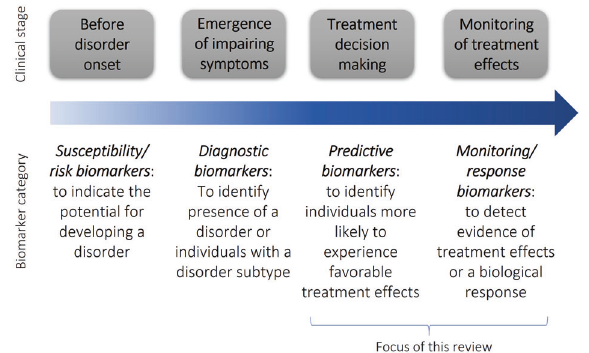
Fig. 1 Timeline showing points through clinical course where different categories of biomarkers (adapted from the Food and Drug Administration Biomarkers, EndpointS, and other Tools Resource [13]) have the potential to impact clinical practices in psychiatry. This review focuses speci fi cally on treatment